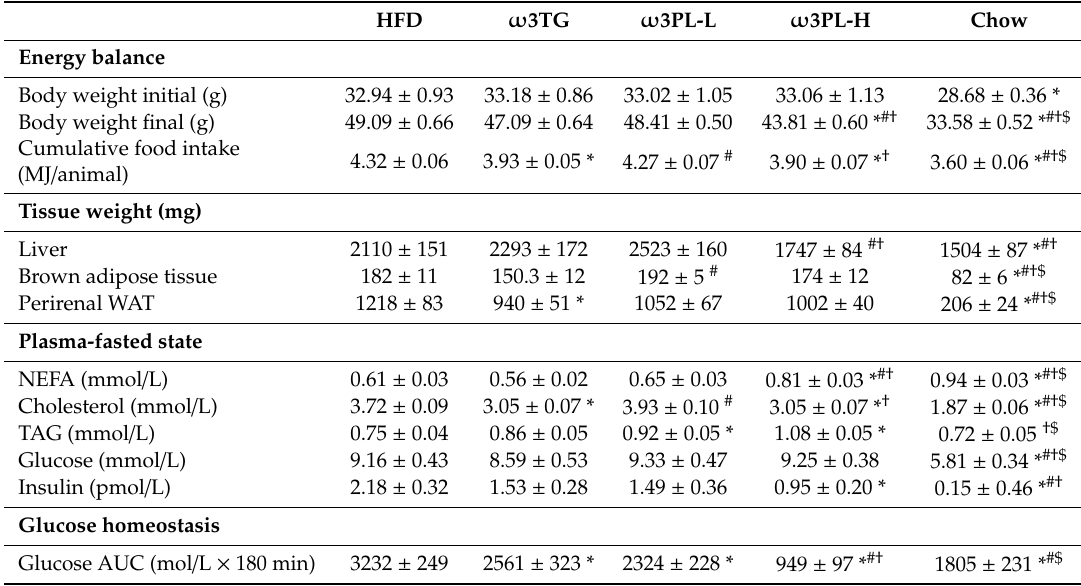
Table 1. Body mass, tissue weights, tissue TAG content and plasma parameters in mice fed HFD alone or supplemented with Omega-3.